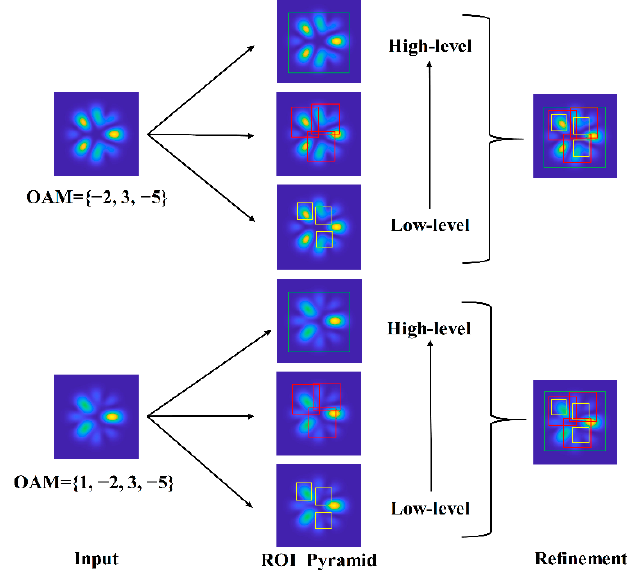
Figure 3. Regions of interest localized by AP-CNN at different levels for different OAM modes. The structure of the modified ResNet18 is shown in Table 1. Table 1. Modified ResNet18 network